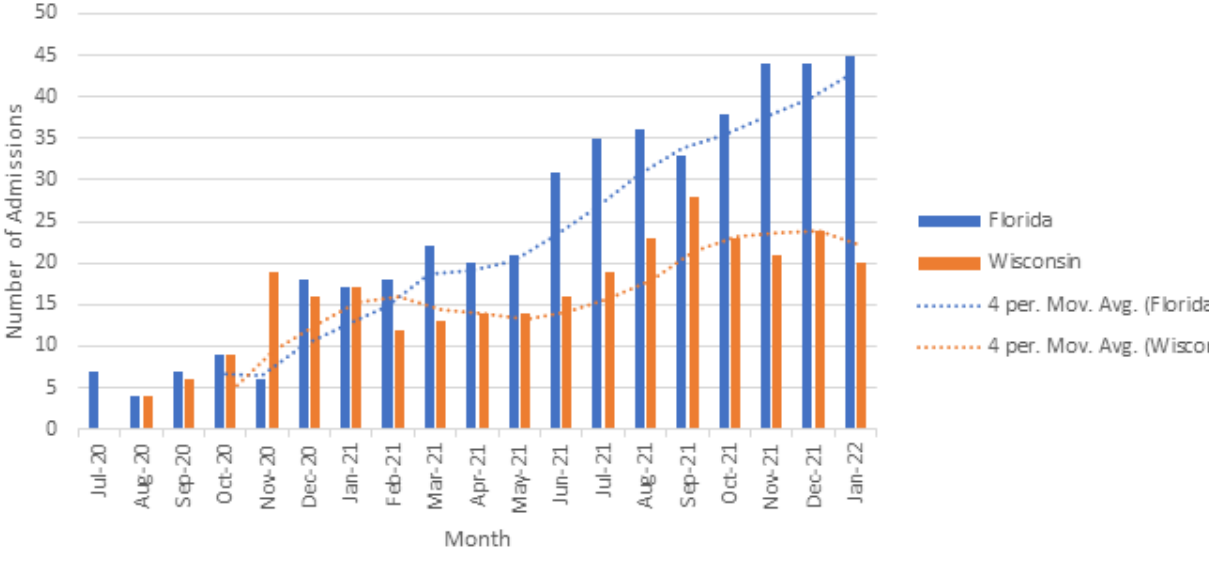
Figure 1. Average Monthly Patient Volumes Between Sites.